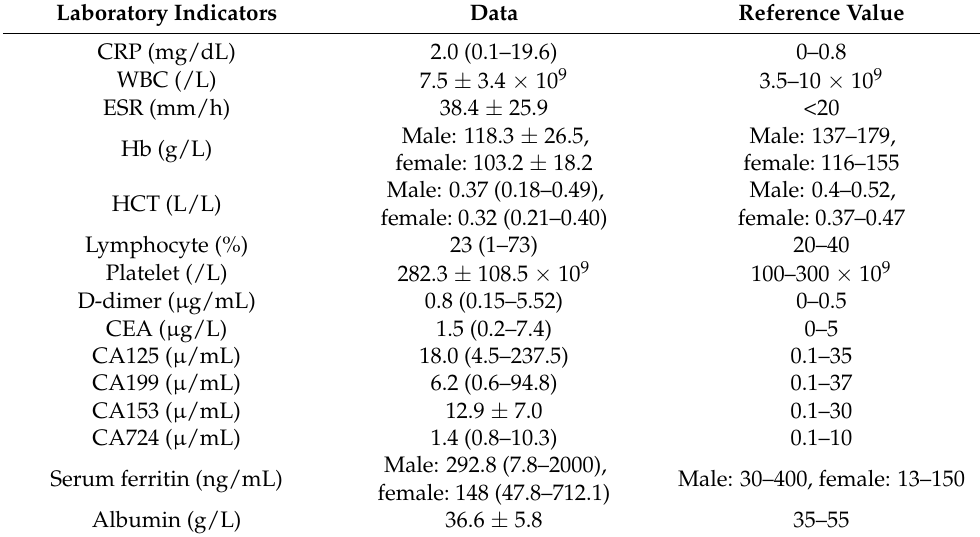
Table 4. Laboratory findings of patients with intestinal